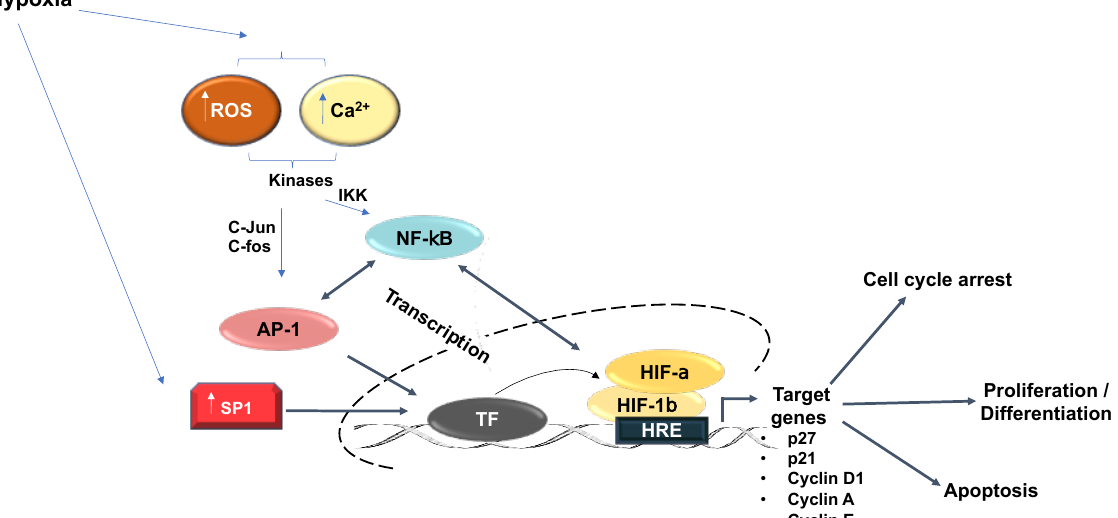
Figure 1. Hypoxia-relevant transcription factor crosstalk. Additional transcription factors than HIF regulate the hypoxia response. Hypoxia increases SP1 expression, which increases SP1 binding to gene promoters and upregulated transcriptional activation of downstream targets. Hypoxia further promotes increased SP1 binding to an upstream GC Box to augment the hypoxia-response element-dependent downstream gene activation. Hypoxia induces AP-1 activity. Mitogen-activated protein kinases (MAPK) activate AP-1 subunits (c-jun/c-fos) in response to hypoxia. Activation of AP-1 heterodimers predominantly exert their effects in cooperation with additional transcription factors including NF κ B and HIF-1 α to activate common target genes including regulation of cell proliferation and apoptosis. NF κ B likewise regulates HIF-1 α transcription.